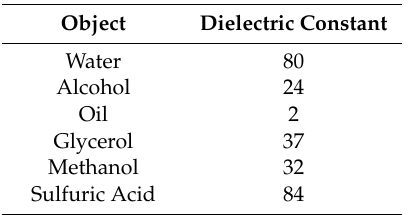
Table 1. The relative dielectric constants of common